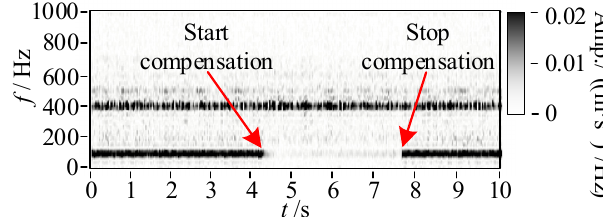
Figure 14. Time-frequency spectrum of base acceleration.